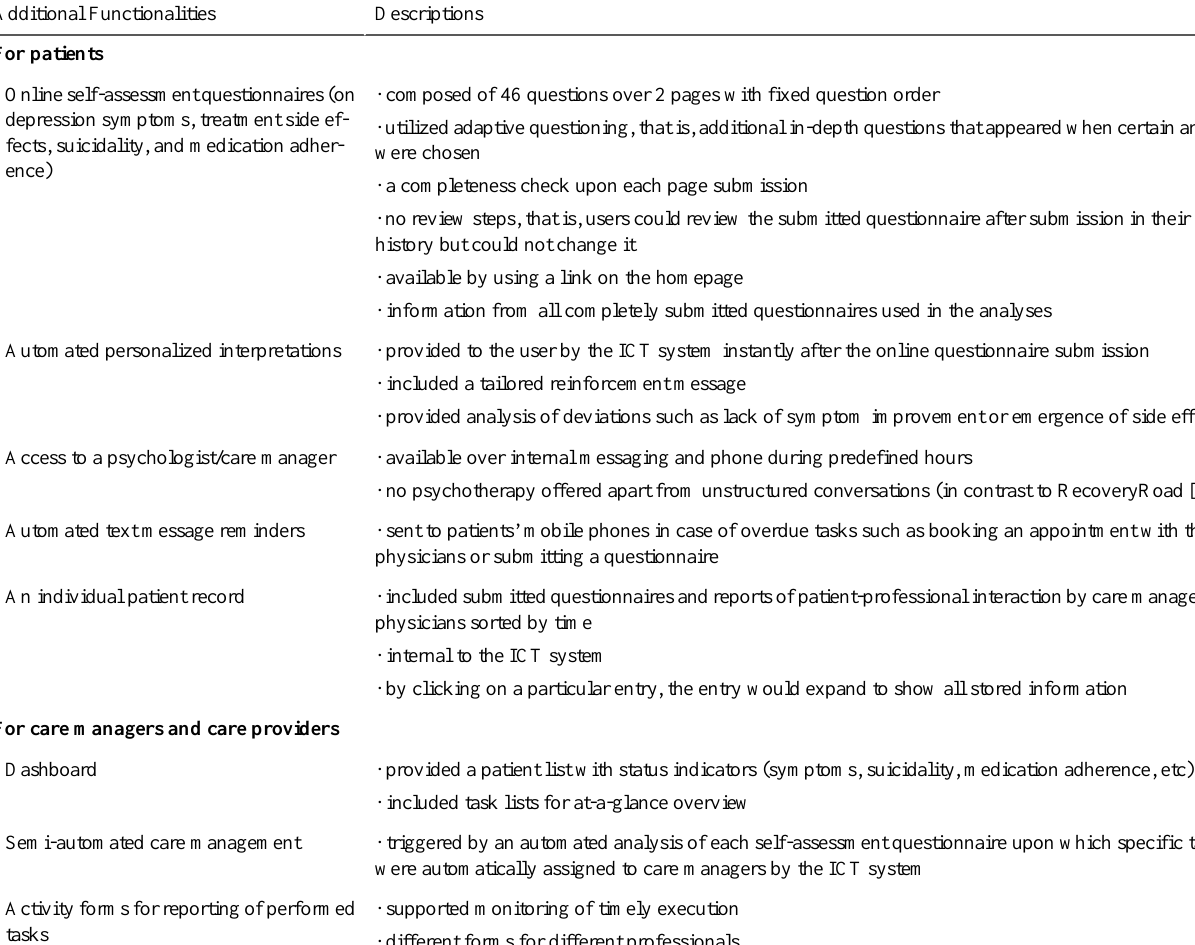
Table 1. Additional functionalities of the ICT system available to patients, care providers, and care